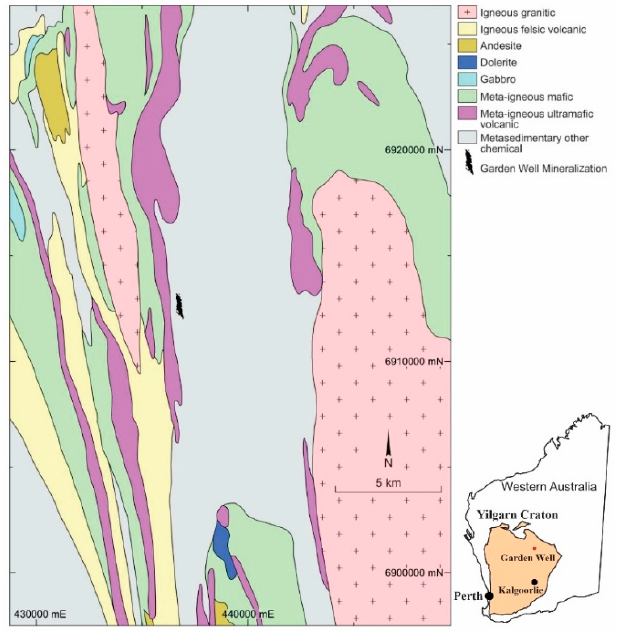
Figure 2. Regional geology of the area surrounding the Garden Well Au deposit [12]. The outline of Garden Well mineralization is also shown.